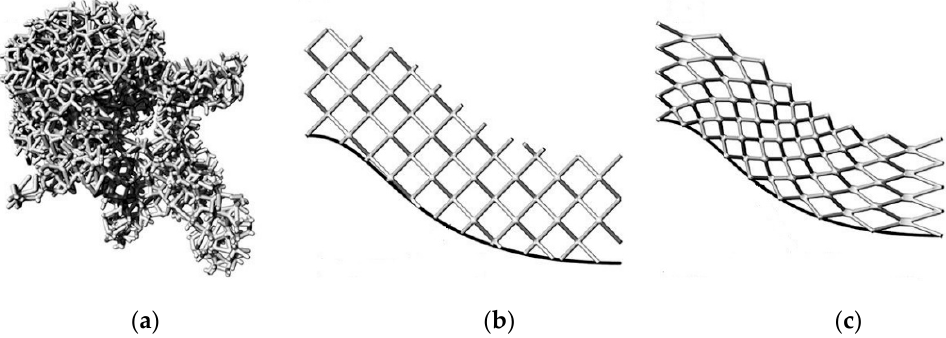
Figure 2. Classification of lattice structures: ( a ) random lattice structures; ( b ) periodic lattice structures; ( c ) periodic lattice structures [23].